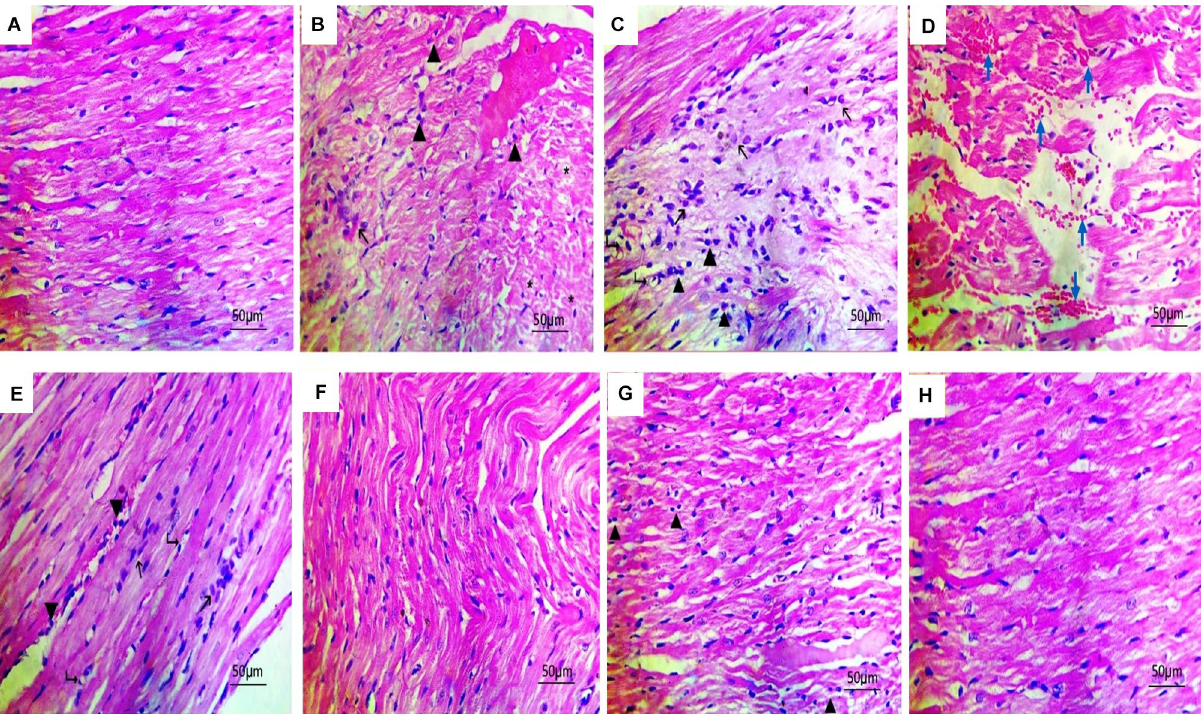
Figure 4. Effect of Br-MSC, metformin, and their combination on cardiac histopathological sections. ( A ) The myocardium section of the control rats showed normal structure and thickness of the cardiac muscle ( B–E ) Heart sections of cisplatin-treated rats showed wide areas of myocytes degeneration (asterisks) replaced by fibroblasts (black arrows) and inflammatory cells (arrowheads) with vacuolated blood vessels (Rt. sided arrowheads) and separation of myocytes by extravasated RBCs (blue arrows) with loss of muscular striations. ( F ) Heart section of Br-MSC treated animals showing improvements of myocyte necrotic changes with nearly normal cardiac muscles (thinning with some fibers disarray) ( G ) Heart section of the metformin-treated group showing improvement of the myocyte’s necrotic changes (thinning with some fibers disarray) with infiltration some inflammatory cells (upward arrowheads) ( H ) Heart section of Br-MSC + metformin treated rats revealing marked improvements of the myocytes with normal structure and thickness. All sections were stained with H&E (× 400) (scale bar = 50 μm). Hisopathological changes Disruption of cardiac muscles architecture